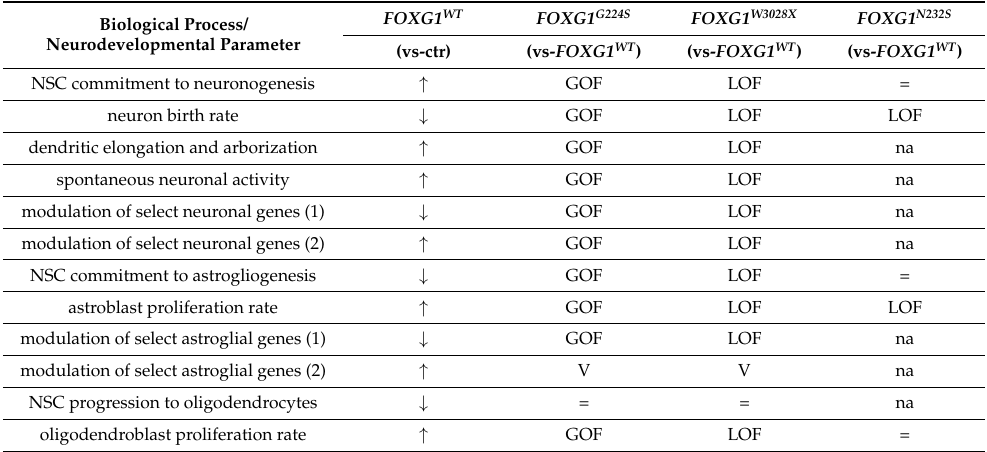
Table 1. Biological activities of FOXG1 alleles: a synopsis. Biological Process/ Neurodevelopmental